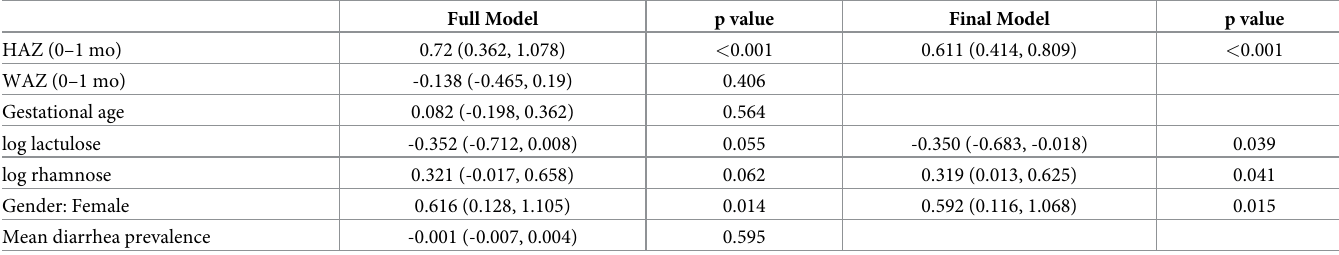
Table 2. Multivariable linear regression model including variables significant at 10% level to predict 24 months HAZ in cases and controls. Full